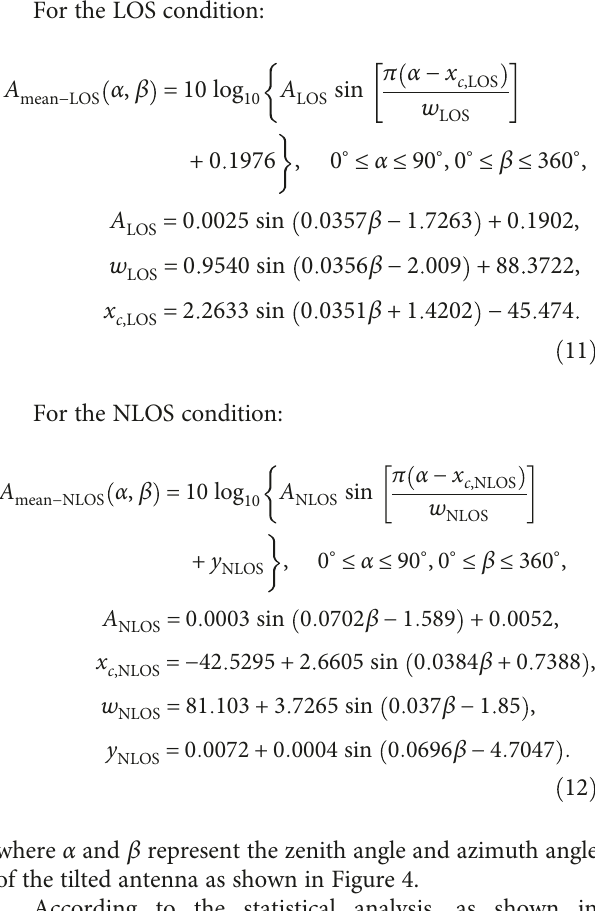
Figure 15: The mean value of the amplitude of the electric fi eld for di ff erent inclination angles in the LOS and NLOS corridors ( β = 0 ∘ ).